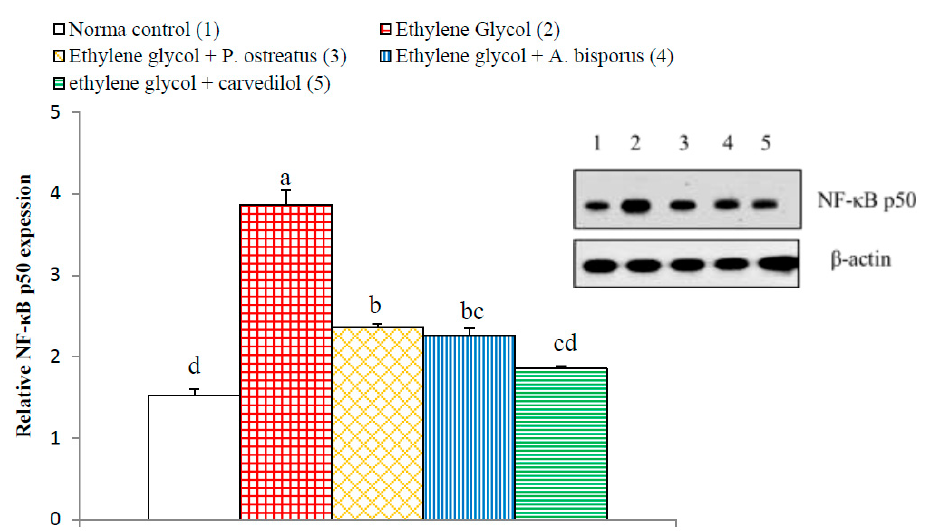
Figure 22. Effect of P. ostreatus and A. bisporus aqueous extracts and carvedilol on relative kidney NF- κ B p50 expression detected by Western blot in ethylene glycol-administered rats. Means which share the same letter(s) are not significantly different.